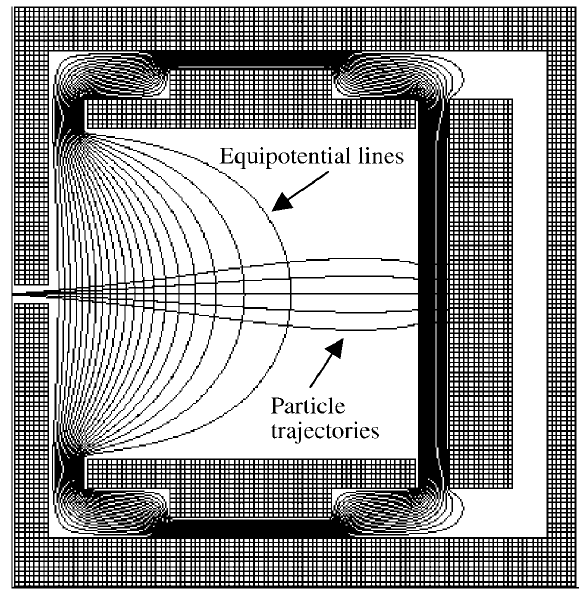
FIG. 2. Equipotential lines and typical beam trajectories in the energy